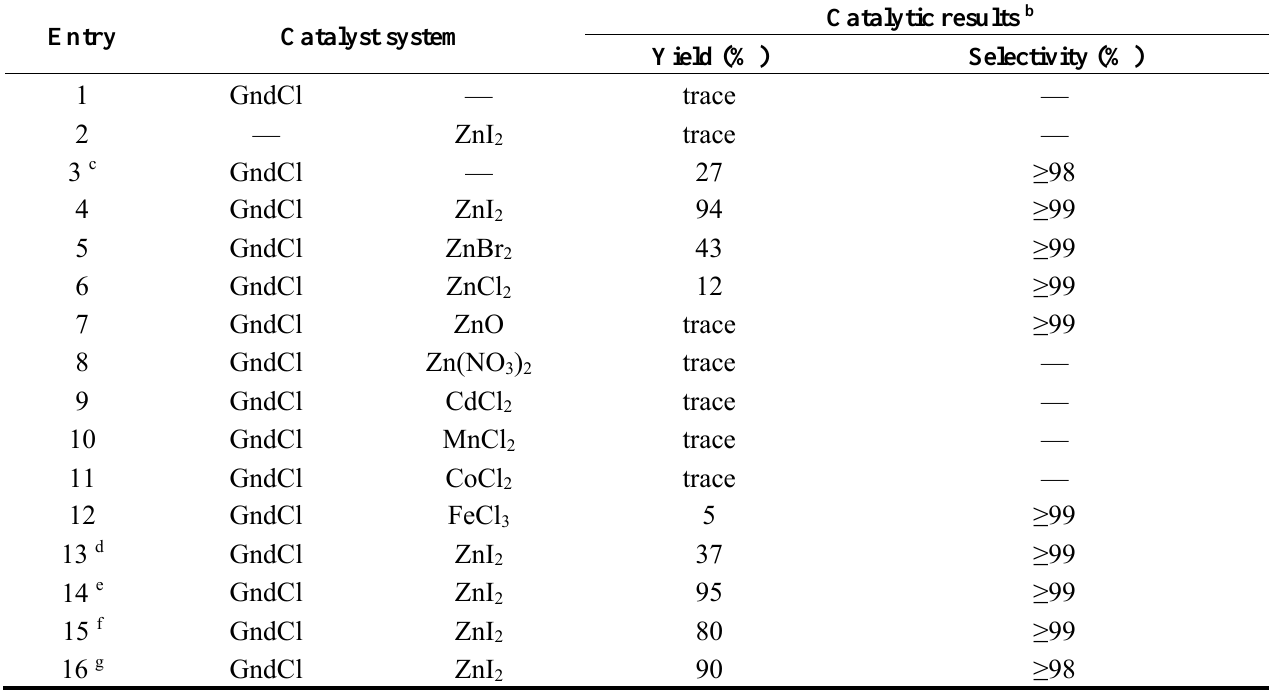
Table 1. Screening of catalysts for the cycloaddition reaction a